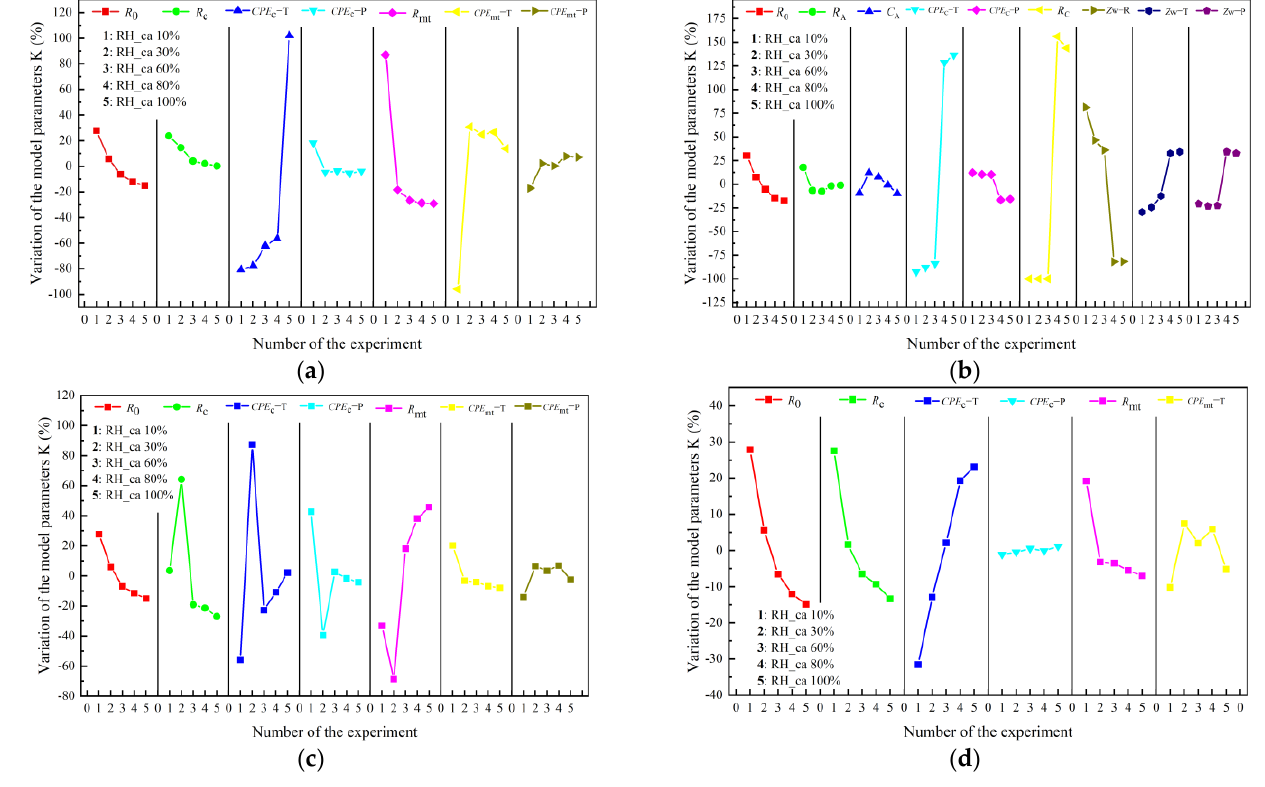
Figure 9. The Changing trend of the model parameters under different air humidity: ( a ) the parameter variations of model A; ( b ) the parameter variations of model B; ( c ) the parameter variations of model C; ( d ) the parameter variations of model D.